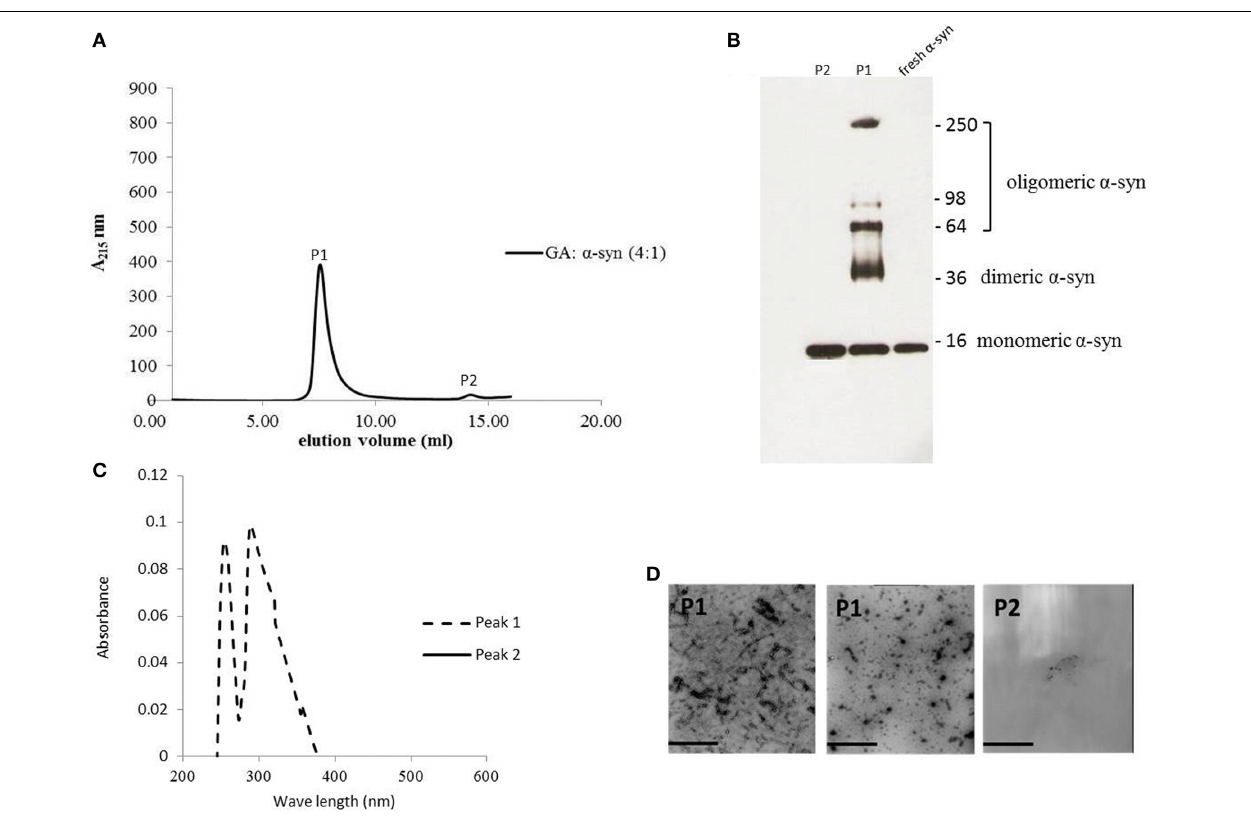
FIGURE 6 | GA binds to α -syn oligomers (GA: α -syn molar ratio of 4:1). (A) Gel filtration profile of the 5-day-aggregated α -syn in the presence of GA at a GA: α -synmolar ratio4:1 ( α -syn concentration = 100 μ M) usinga superdex 200 SE column. P1 sample contains the isolated fractions corresponding to the oligomeric peak and P2 the isolated fractions corresponding to the monomeric peak. The elution was monitored at the absorbance wavelength of 215nm.